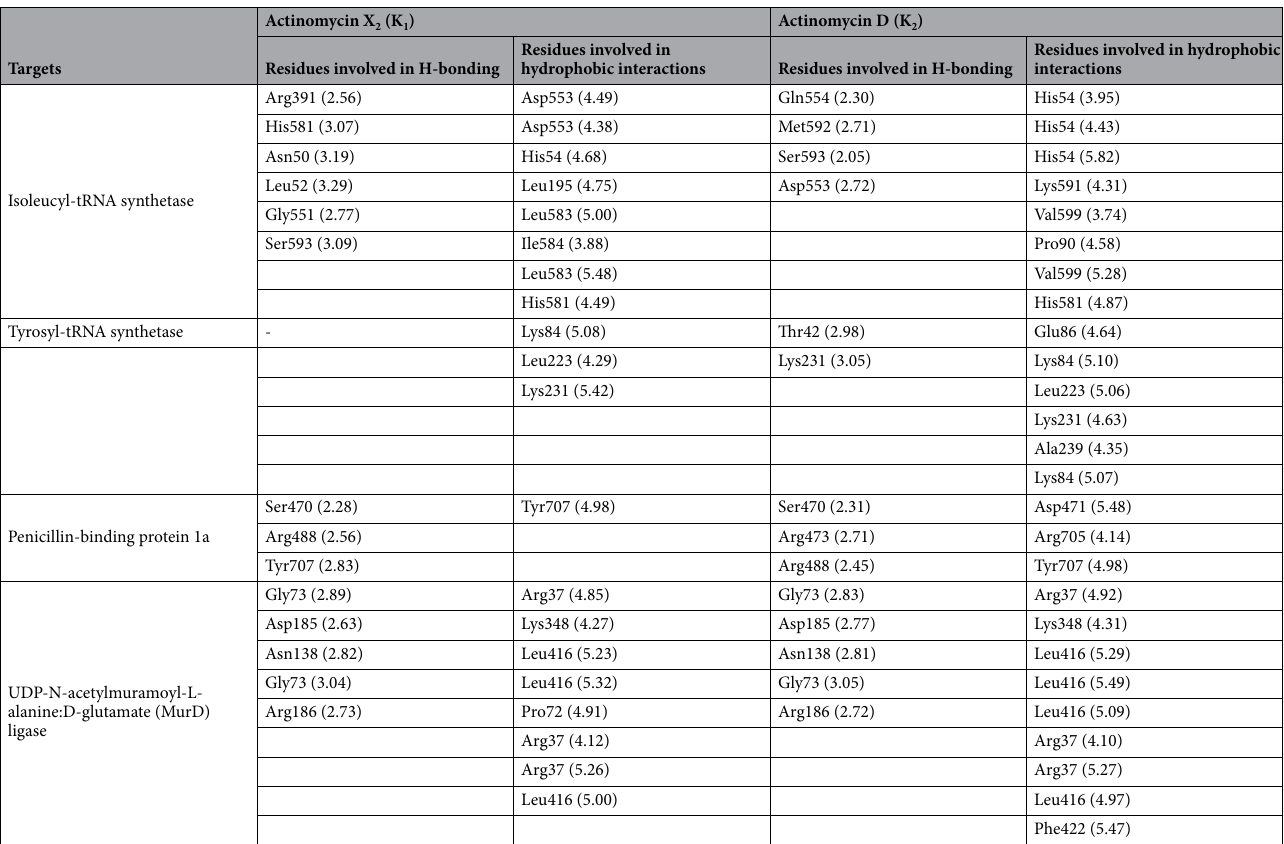
Table 6. Intermolecular interactions observed between docked compounds K 1 and K 2 and drug targets. Bond distances are given in